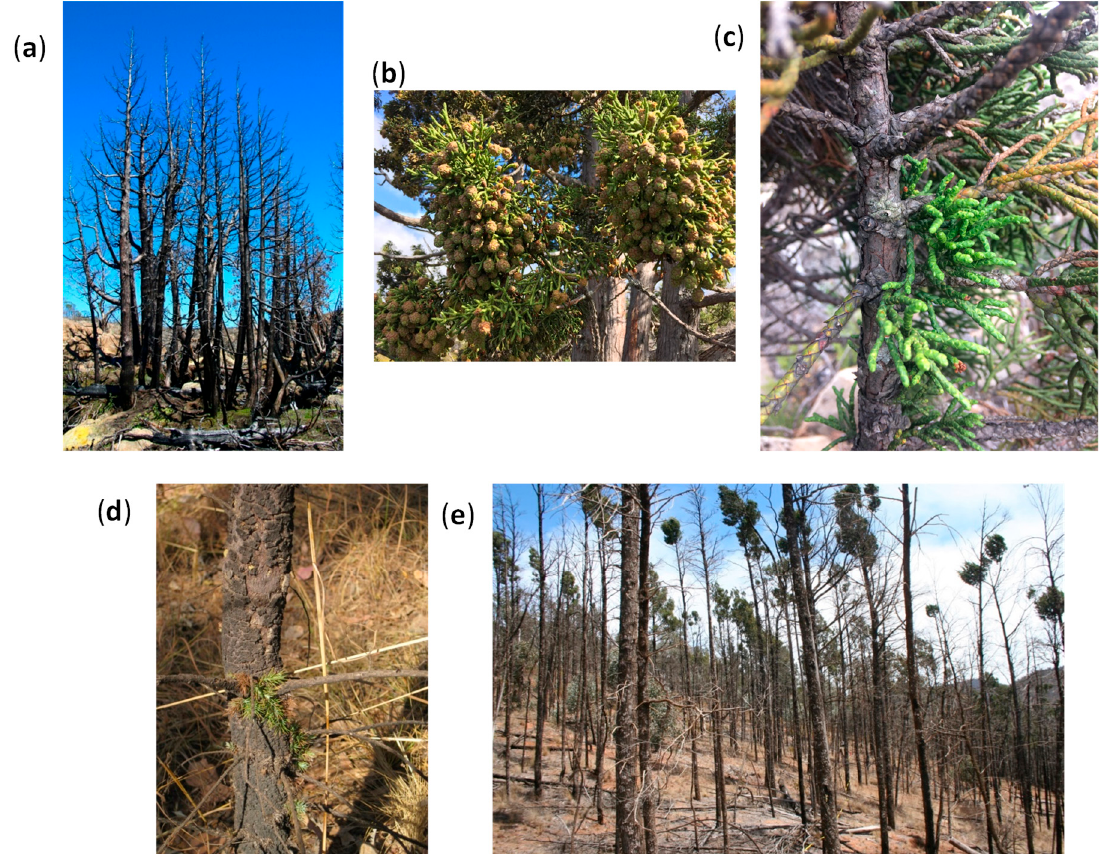
Figure 1. Resprouting response after fire is not binary, but falls on a continuum, as illustrated by some fire-intolerant Australian conifer species. ( a ) Athrotaxis cupressoides , endemic to sub-alpine areas of Tasmania, can form extensive clumps through clonal regeneration, but ( b ) is also a mast seeder. It is a facultative resprouter/seeder that is intolerant of canopy fire, but ( c ) a few stems have resprouted after severe fire in 2016. In drier regions of Australia, the fire-intolerant obligate seeders ( d ) Callitris intratropica and ( e ) Callitris glaucophylla , usually regarded as non-resprouters, can also weakly resprout after canopy fire. Photos: ( a )–( c ), Aimee Bliss, and ( d )–( e ), Lynda Prior.